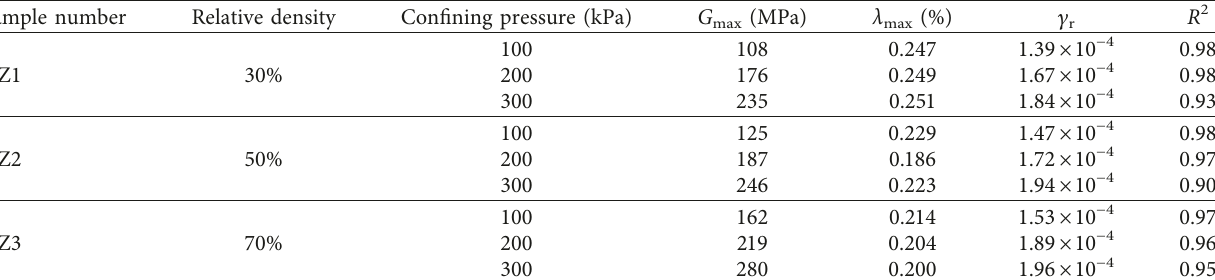
c and λ - c under different mixing ratios: (a) D max - Table 4: Fitting results of test